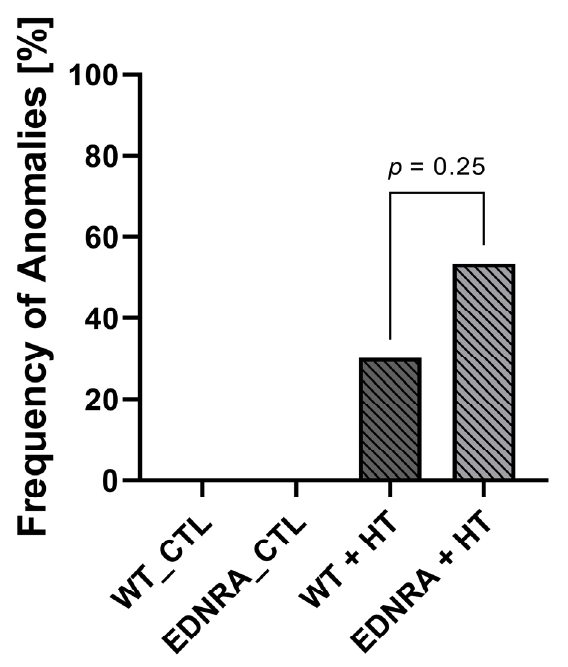
Figure 4. Vascular anomalies (ectasia and aneurysm) were observed only in HT-induced rats